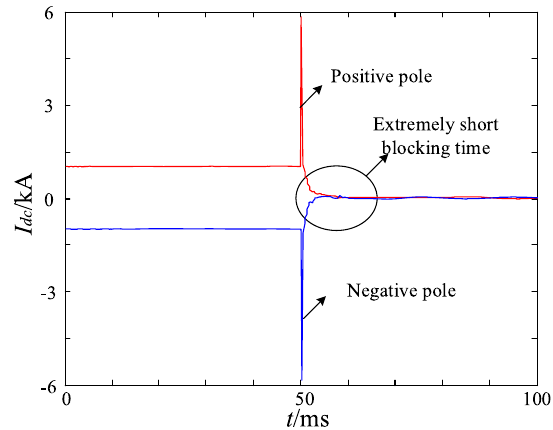
Fig. 1 Fault blocking of full bridge MMC